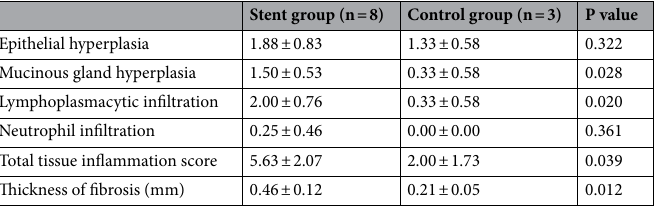
Table 2. Comparison of degree of tissue damage and fibrosis between stent and control groups. Data are mean ± standard